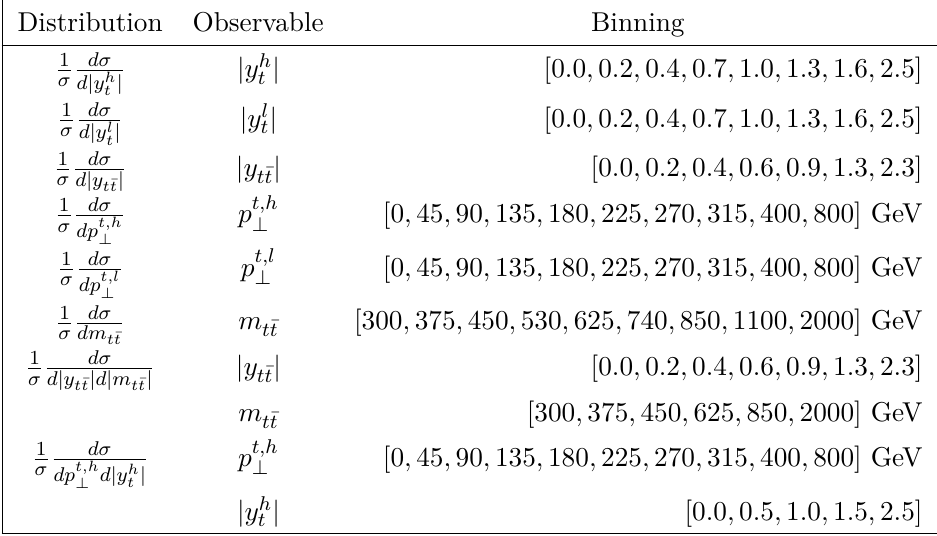
Table 1 . Distributions provided in ref. [65] and included in the fit in this